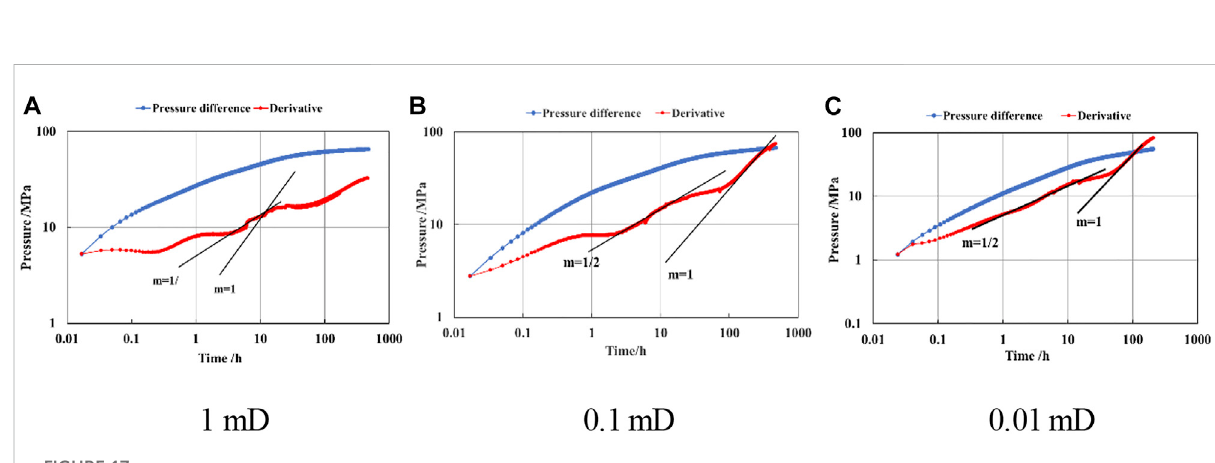
FIGURE 17 Log – log curve of pressure difference and the derivative in different permeability zones. (A) 1 mD, (B) 0.1 mD, and (C) 0.01